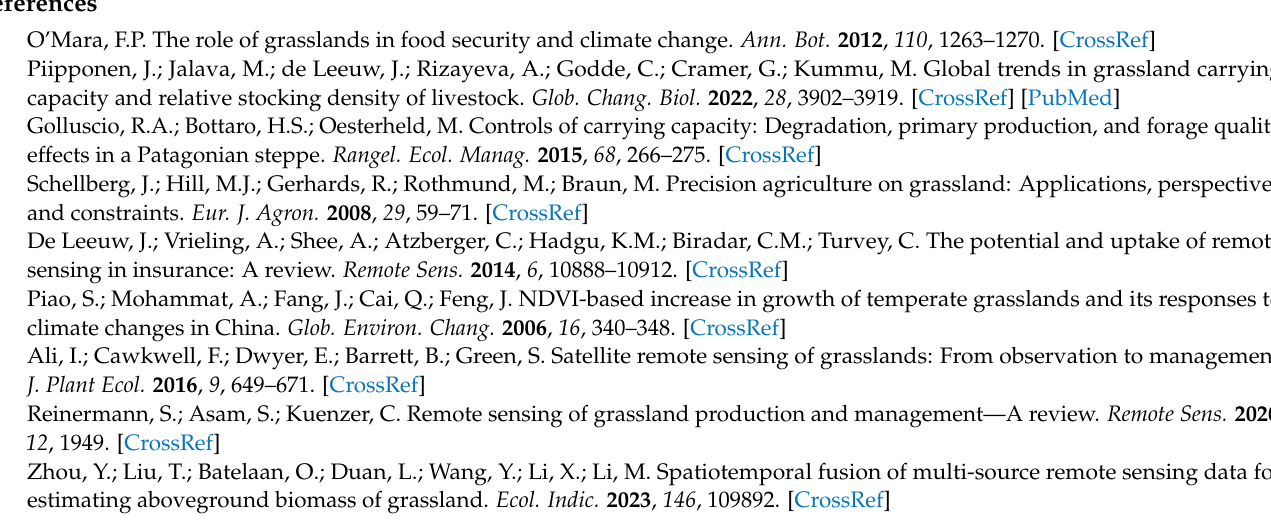
2 MSI instrument. Table S3: A summary of multiple regression analysis for forage biomass. Table S4: A summary of multiple regression analysis for forage CF area . Table S5: A summary of multiple regression analysis for forage CP area . Table S6: Livestock carrying capacity (AU per ha) estimated using forage biomass (DM), crude protein (CP), and the metabolizable energy (ME) respectively. Figure S1: The amount of grass biomass (above-ground biomass, AGB) corresponding to each grass- cutting in an example quadrat. Figure S2: Correlations between LSWI retrieved from field spectral data and in-situ S2 dataset (2021/07/31) for 19 sampling plots. Figure S3: An example of spectral changes after each grass-cutting. Figure S4: Changes in predicted forage biomass, CF area and CP area (a) and the ratio between biomass based and CP area based carrying capacity (b) with mean annual temperature (MAT). Figure S5: Correlations between LSWI retrieved from canopy reflectance with soil background (LSWI) and without soil background (LSWI veg ) for 19 sampling